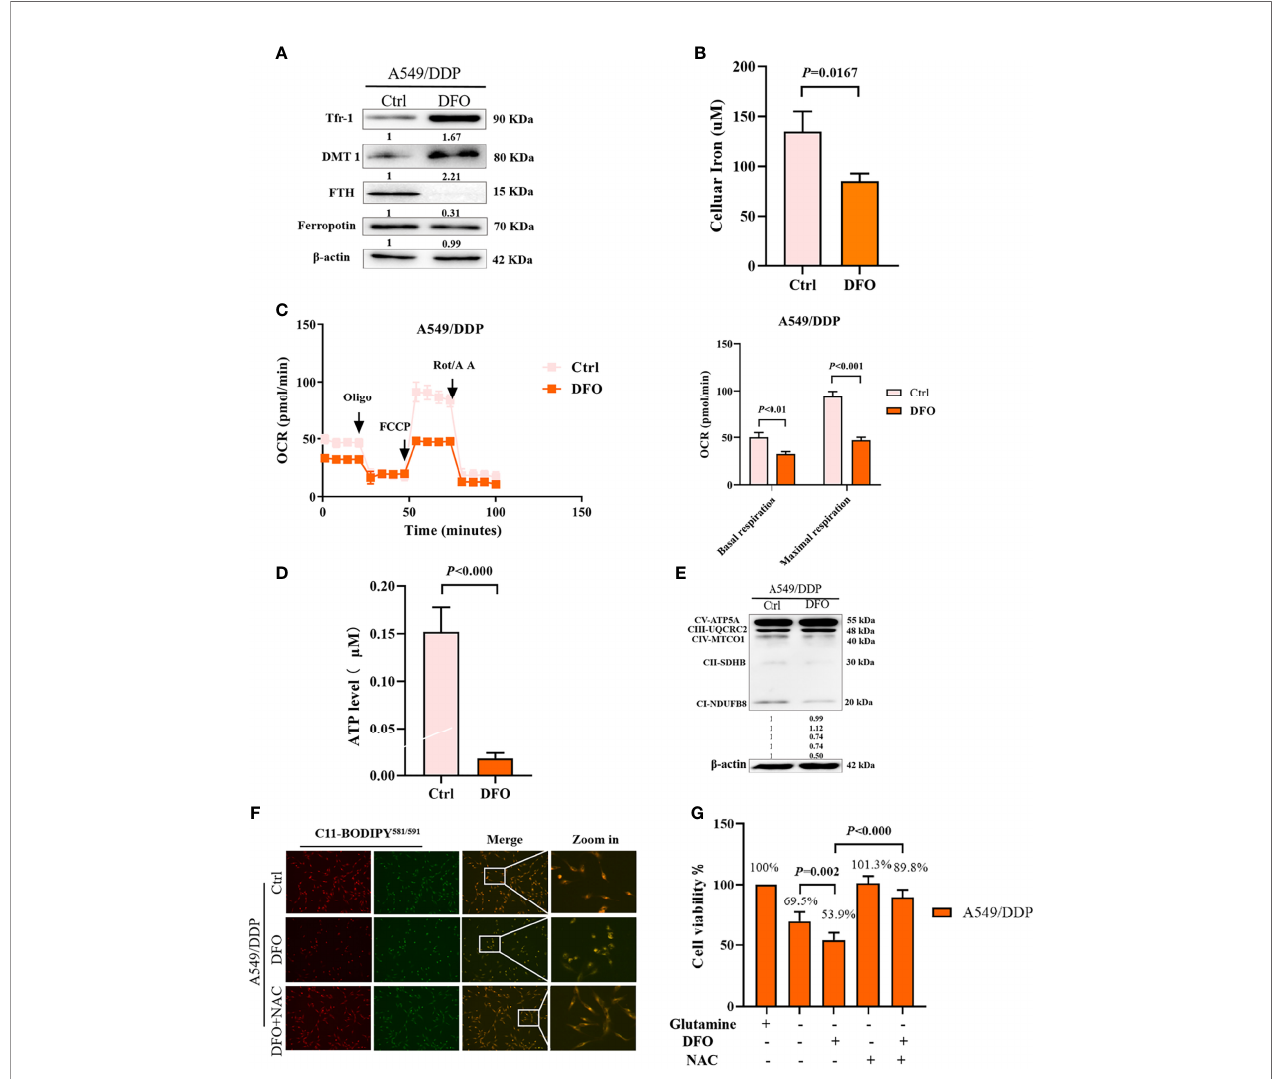
FIGURE 5 | DFO destabilizes iron metabolism, impairs mitochondrial respiration, and induces oxidative-stress – mediated cell death in A549/DDP cells during glutamine deprivation. Effects of DFO (100 m M; 48 h) on: (A) iron uptake and storage-related protein expression in A549/DDP cells during glutamine deprivation for 48 h; (B) cellular iron concentration in A549/DDP cells during glutamine deprivation for 48 h; (C) ETC-dependent oxygen consumption as represented by basal and maximal respiration measured by Seahorse XF assay in A549/DDP cells during glutamine deprivation for 48 h; (D) ATP levels of A549/DDP cells cultured in a glutamine-restricted condition for 48 h; and (E) on respiration complex protein expression in A549/DDP cells cultured without glutamine for 48 h. (F) Effects of DFO (100 m M; 48 h) and NAC (5 mM; 48 h) on lipid peroxidation as represented by C11-BODIPY 581/591 fl uorescence in A549/DDP cells during glutamine deprivation for 48 h. (G) Viability of A549/DDP cells after DFO (100 m M; 48 h) and NAC (5 mM; 48 h) treatment during glutamine deprivation for 48 h. All experiments were repeated at least thrice, and the results are expressed as mean ±